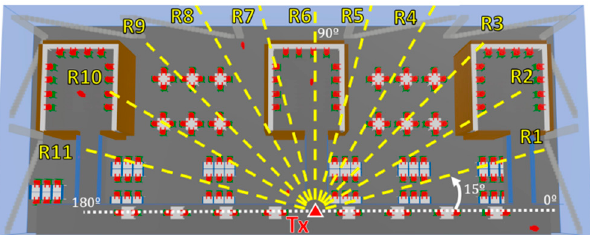
Figure 8. Transmitter antenna beamforming and radials of the receiver measurement points for the 28 and 60 GHz operating frequencies when the transmitter is placed on the first floor.